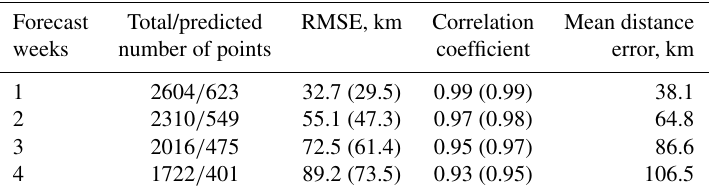
Table 5. Statistics of our multiple linear regression model for different forecast times of eddy propagation positions in terms of longitude